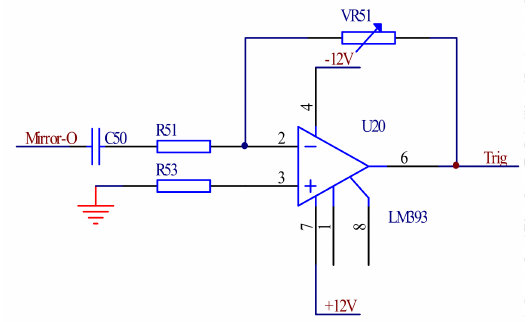
Figure 10. The synchronous trigger circuit.